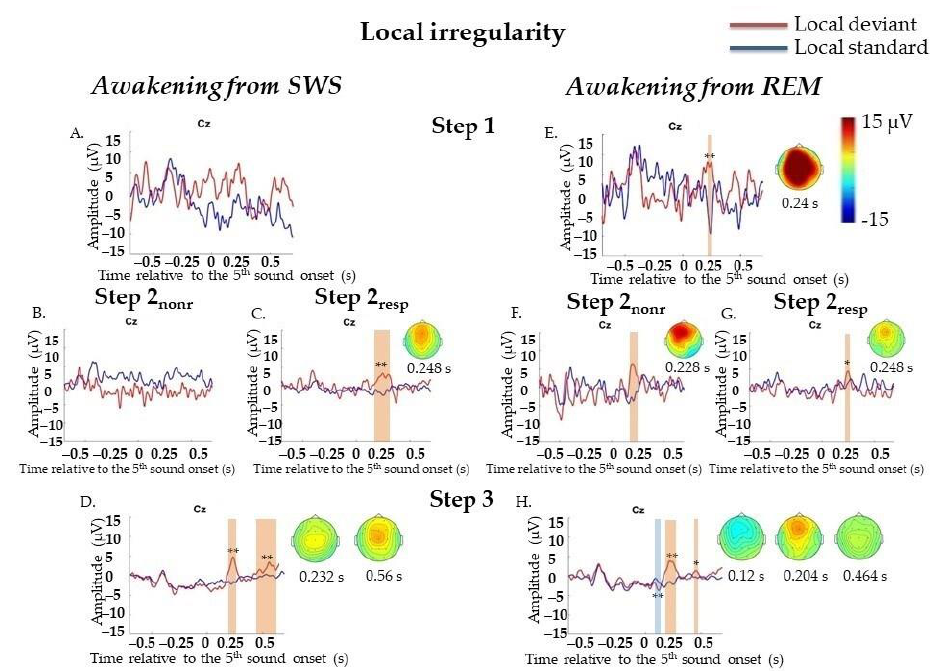
Figure 3. Event-related responses to violation of local regularity in the sessions with awakening from slow-wave sleep and rapid eye movement sleep. SWS, slow-wave sleep; REM, rapid eye